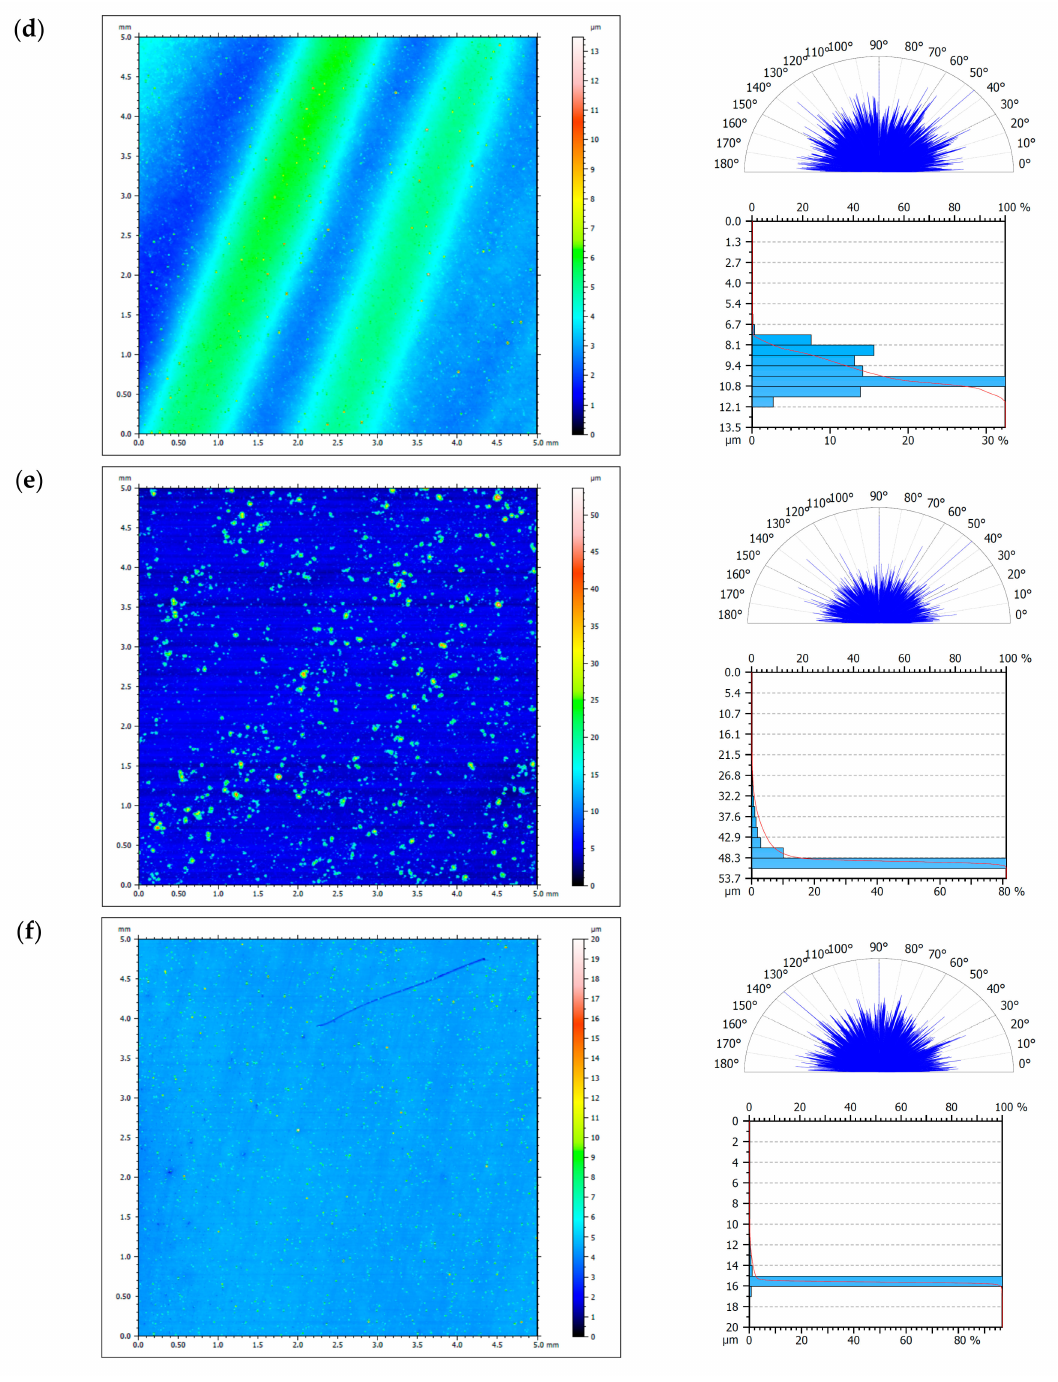
Figure 5. Surface topography of the AW-7075 alloy and Ni-P and Ni-P / Si 3 N 4 coatings. (( a )—AW-7075, ( b )—Ni-P(10 µ m), ( c )—Ni-P(20 µ m), ( d )—Ni-P(30 µ m), ( e )—Ni-P / Si 3 N 4 (2 g / dm 3 ), ( f )—Ni-P / Si 3 N 4 (5 g / dm 3